Question: Looking at the figure, what chart type is it?
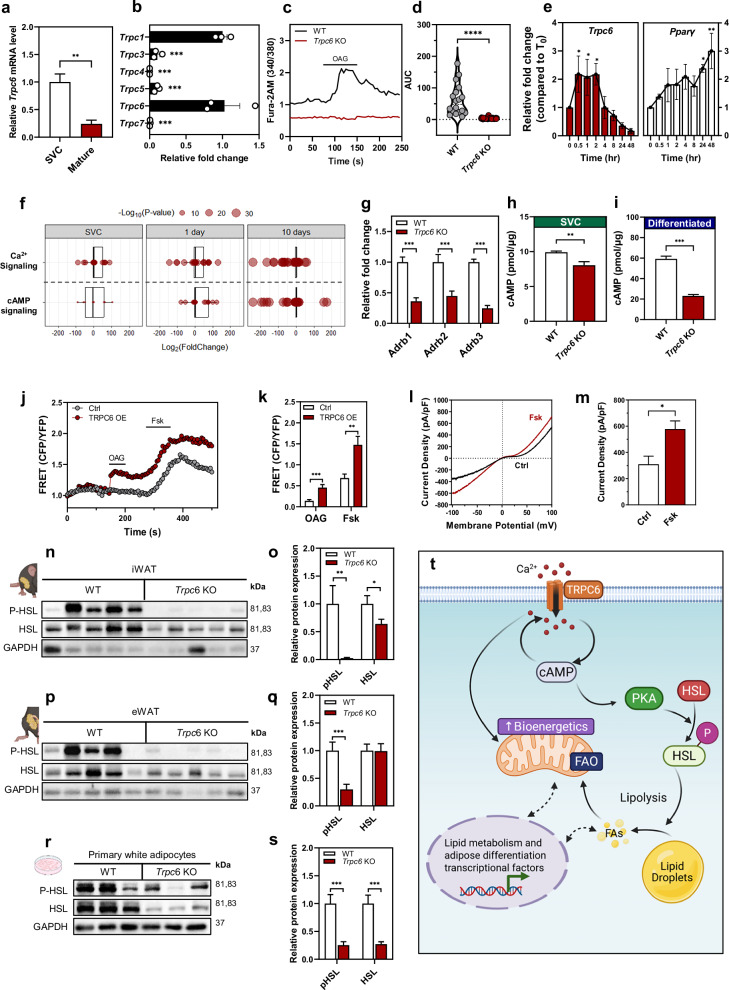
Answer: heatmap